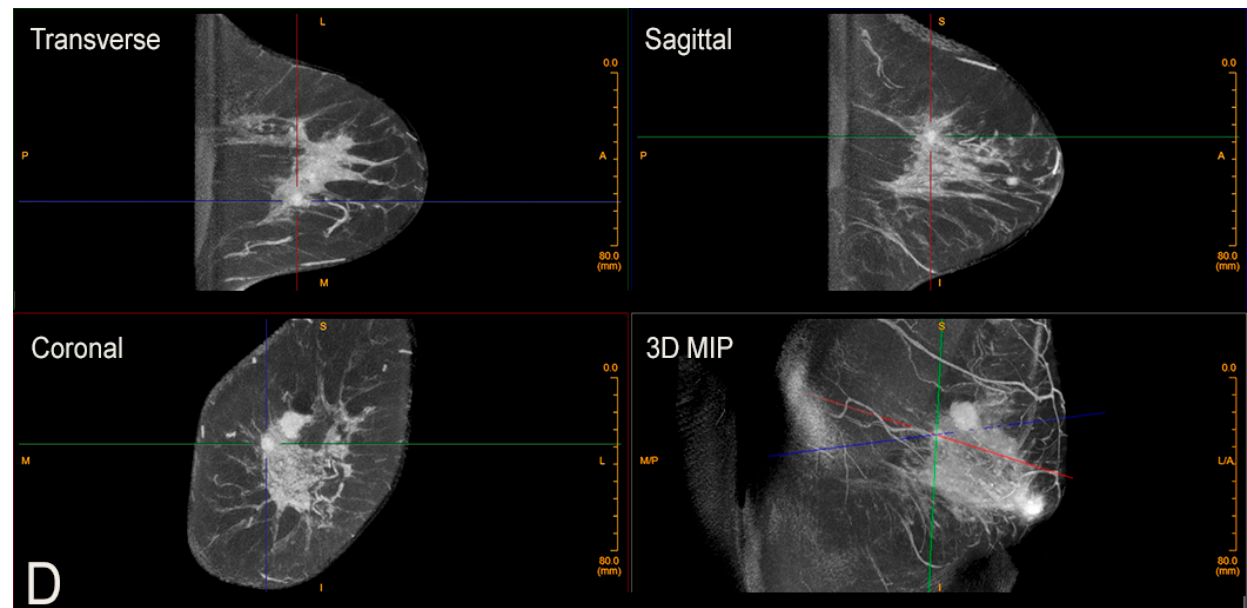
Figure 5. Contrast-enhanced CBBCT. Left CC ( A ) and MLO ( B ) views demonstrate two masses (black and white arrows). ( C ) Contrast-enhanced CBBCT with gridlines marking the mass corresponding to the black arrow on mammography. ( D ) Contrast-enhanced CBBCT with gridlines marking the mass corresponding to the white arrow on mammography.